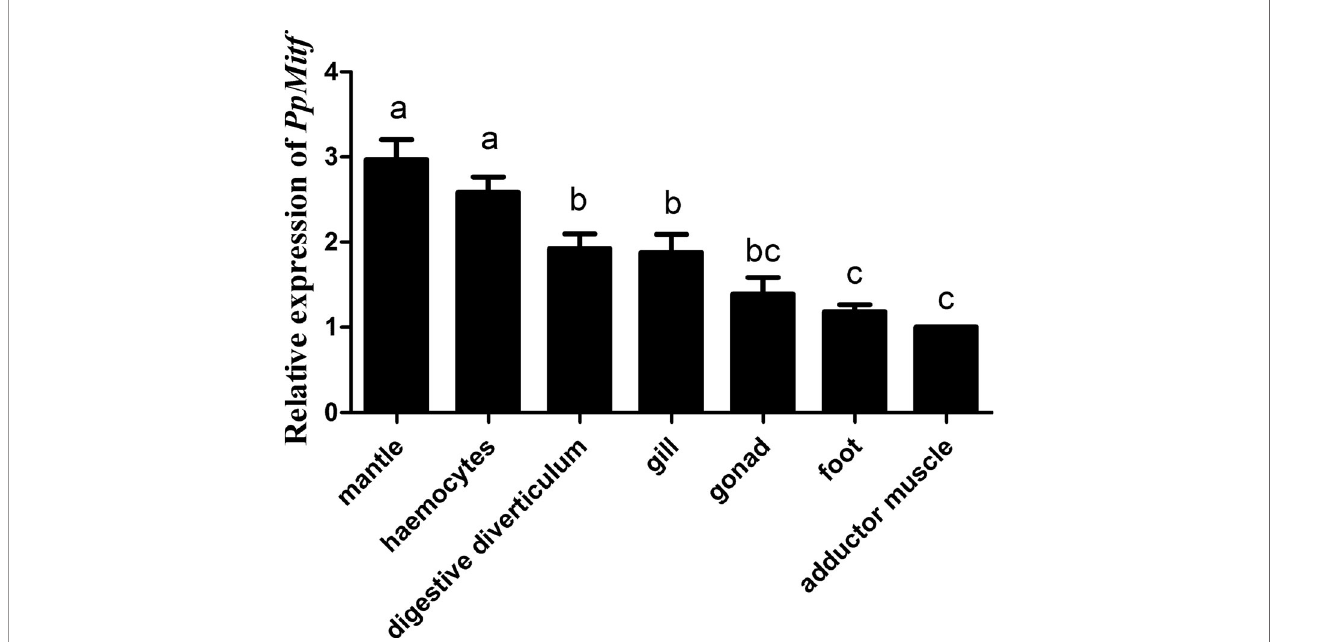
FIGURE 3 | The expression of PpMitf in different tissues was validated by qRT-PCR. The abundance of PpMitf mRNA was normalized to that of b -actin of P. penguin . The data were represented as mean ± SD ( N = 5). Different letters (a, b, bc and d) meant signi fi cant difference among these columns ( P < 0.05).